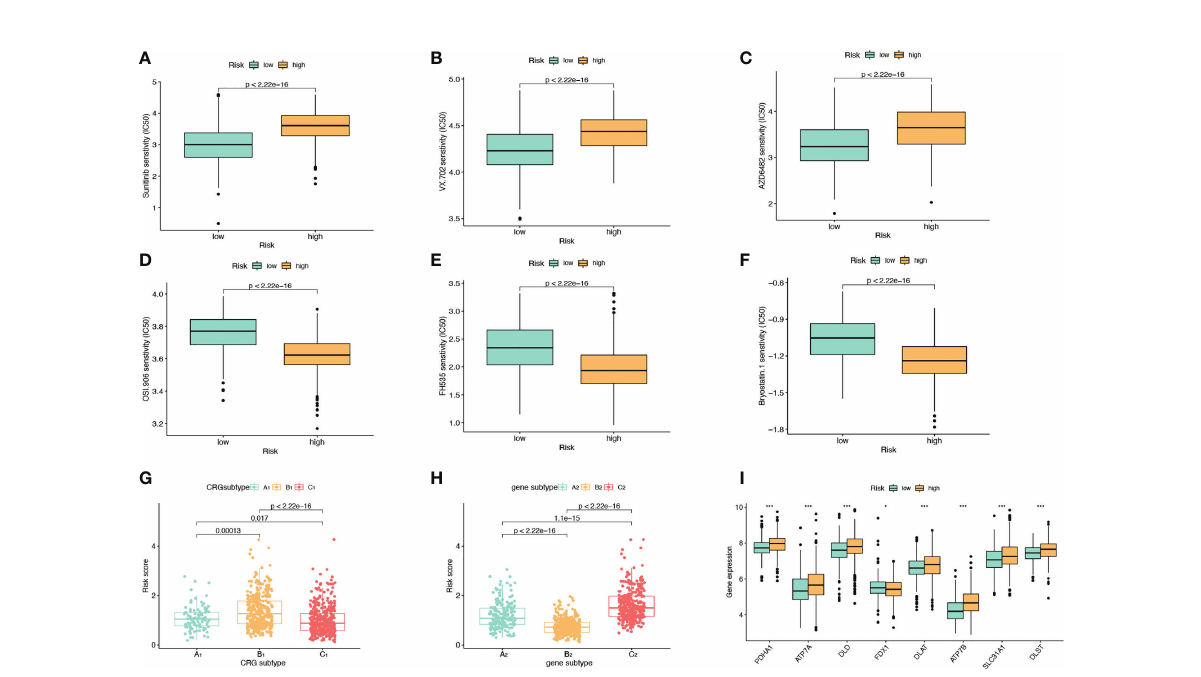
FIGURE 6 Drug Sensitivity Analysis. (A – C) The sensitivity of the low-risk group to Sunitinib, VX.702, AZD6482 was higher than that of the high-risk group. The abscissa is the low-risk group and the high-risk group, and the ordinate is the value of the drug IC50. (D – F) The high-risk group had higher sensitivity to OSI.906, FH535, and Bryostatin.1 than the low-risk group. (G) Risk scores for A 1 , B 1 , and C 1 subtypes in CRGs molecular subtypes. (H) Risk scores for A 2 , B 2 , C 2 subtypes in genotyping. (I) Expression levels of CRGs in high and low risk groups.